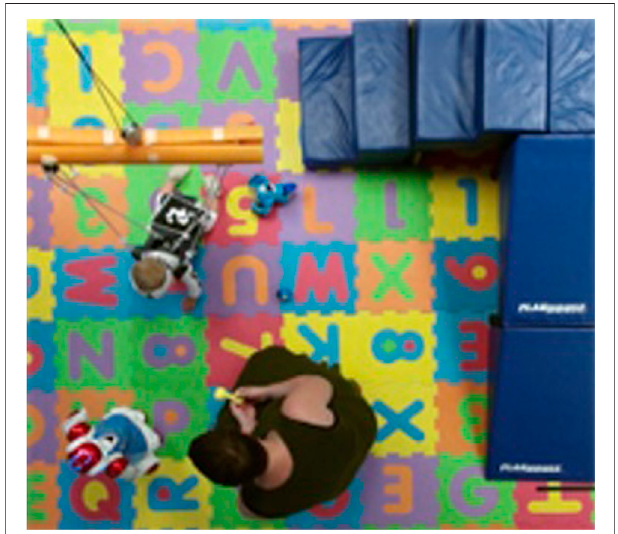
FIGURE 6 | Instance of play-based child-robot social interaction. Two robots are visible in the scene: a small humanoid NAO , and a differential-drive small mobile robot toy DASH .